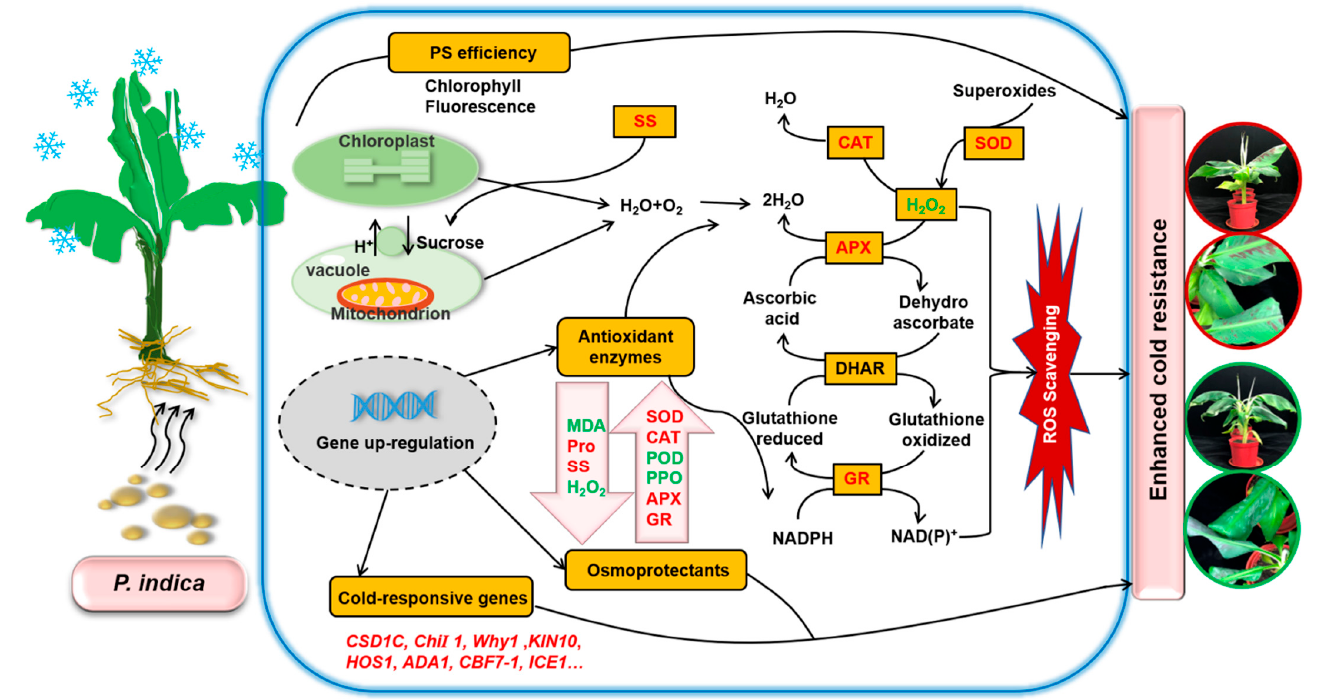
Figure 6. Schematic representation of Piriformospora indica symbiotic association-mediated banana cold stress tolerance. PS efficiency, antioxidant enzymes, osmoprotectants, and cold-responsive genes played an essential beneficial role in P. indica -induced cold resistance in banana. The parameters and gene names in red indicate a higher level and upregulation, while the green color indicates a lower level and downregulation. This figure is drawn according to Kumar et al. [58], Gill et al. [59], and Nath et al. [50].